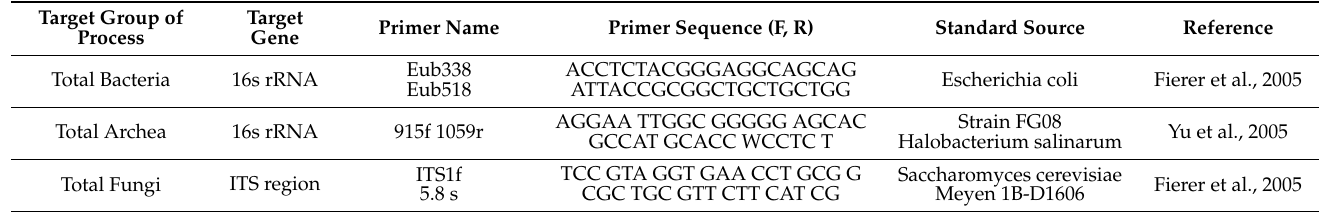
Table 1. Information about primers and standards for